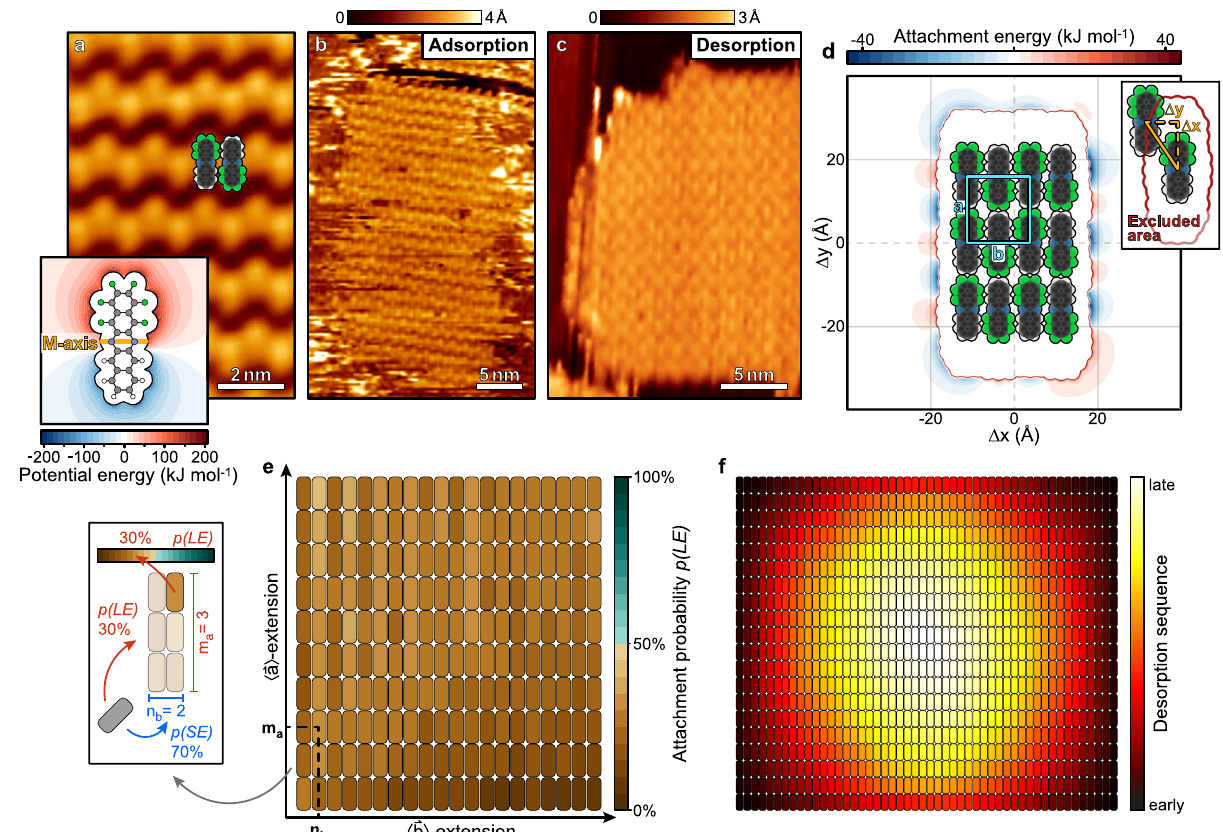
Fig. 3 | Experimental and computational analysis of M-F 6 PEN nanosheet for- mation. a STM micrograph of a complete monolayer of M-F 6 PEN adsorbed on MoS 2 (U=2.0V, I=400 pA). Inset: Plot of the outer electrostatic potential of a M-F 6 PENmolecule(C 20 N 2 H 6 F 6 ) probed byanelectron. Carbon atomsare shownin grey,hydrogenatomsinwhite, fl uorineatomsingreen,andnitrogenatomsinblue. The orangeline marksthe M-axisof the molecule. b , c STMmicrographs ofislands of M-F